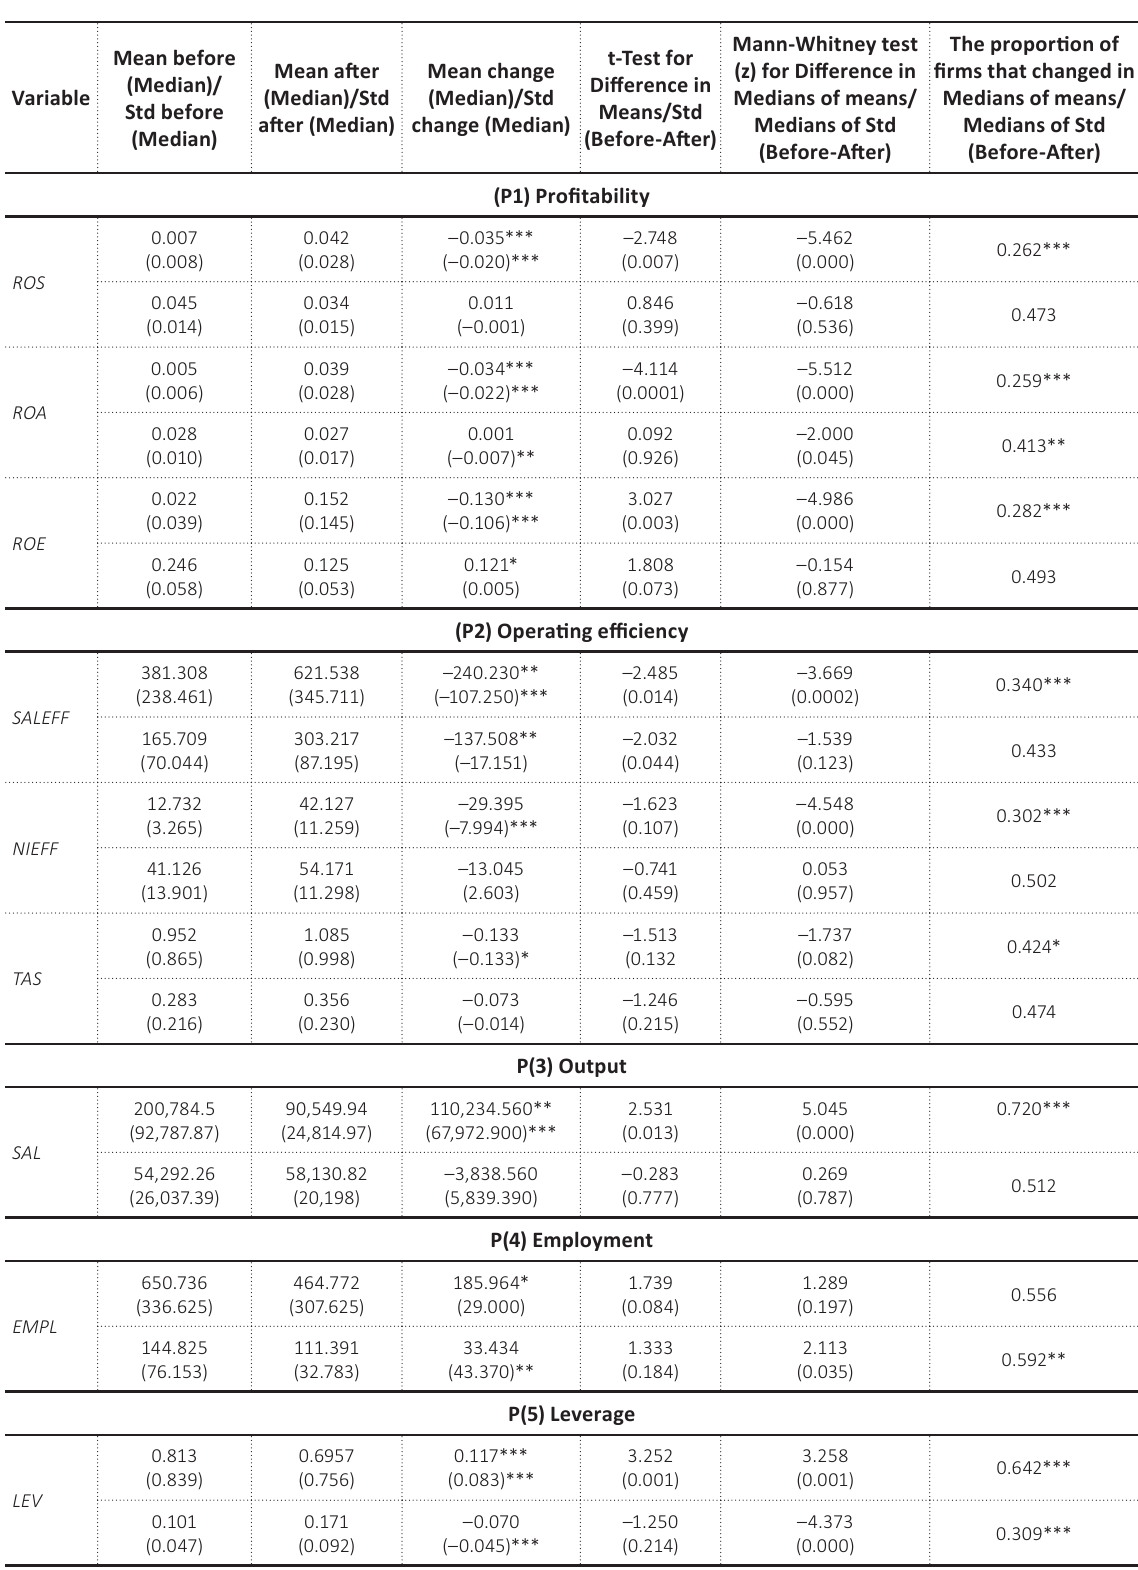
Table A2. Performance changes of privatized SOEs in the manufacturing and construction sectors (privatized SOEs with tax